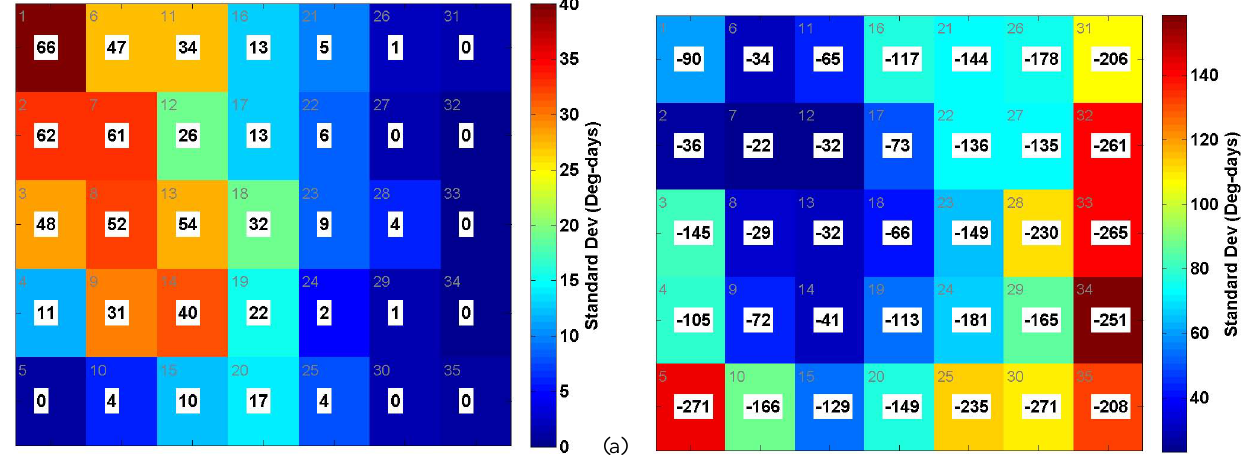
Fig. 5. Mean positive (a) and negative (b) degree-days for each SOM cell over 1961–2009 at Lake El’gygytgyn. Numbers are mean value and colors are standard deviation. For example, patterns 5 and 30 have the same negative degree-days ( − 271) but pattern 5 has about 50% more variation, indicating that it is more likely to be responsible for inter-annual variations; these two patterns alone total nearly the same as the total positive degree-days for all patterns (a) . Pattern 34 alone has shown a 2- σ variation in range that is nearly equal to all positive degree- days, indicating that winters have a higher sensitivity and demonstrated capability for affecting annual means and inter-annual variability in the modern